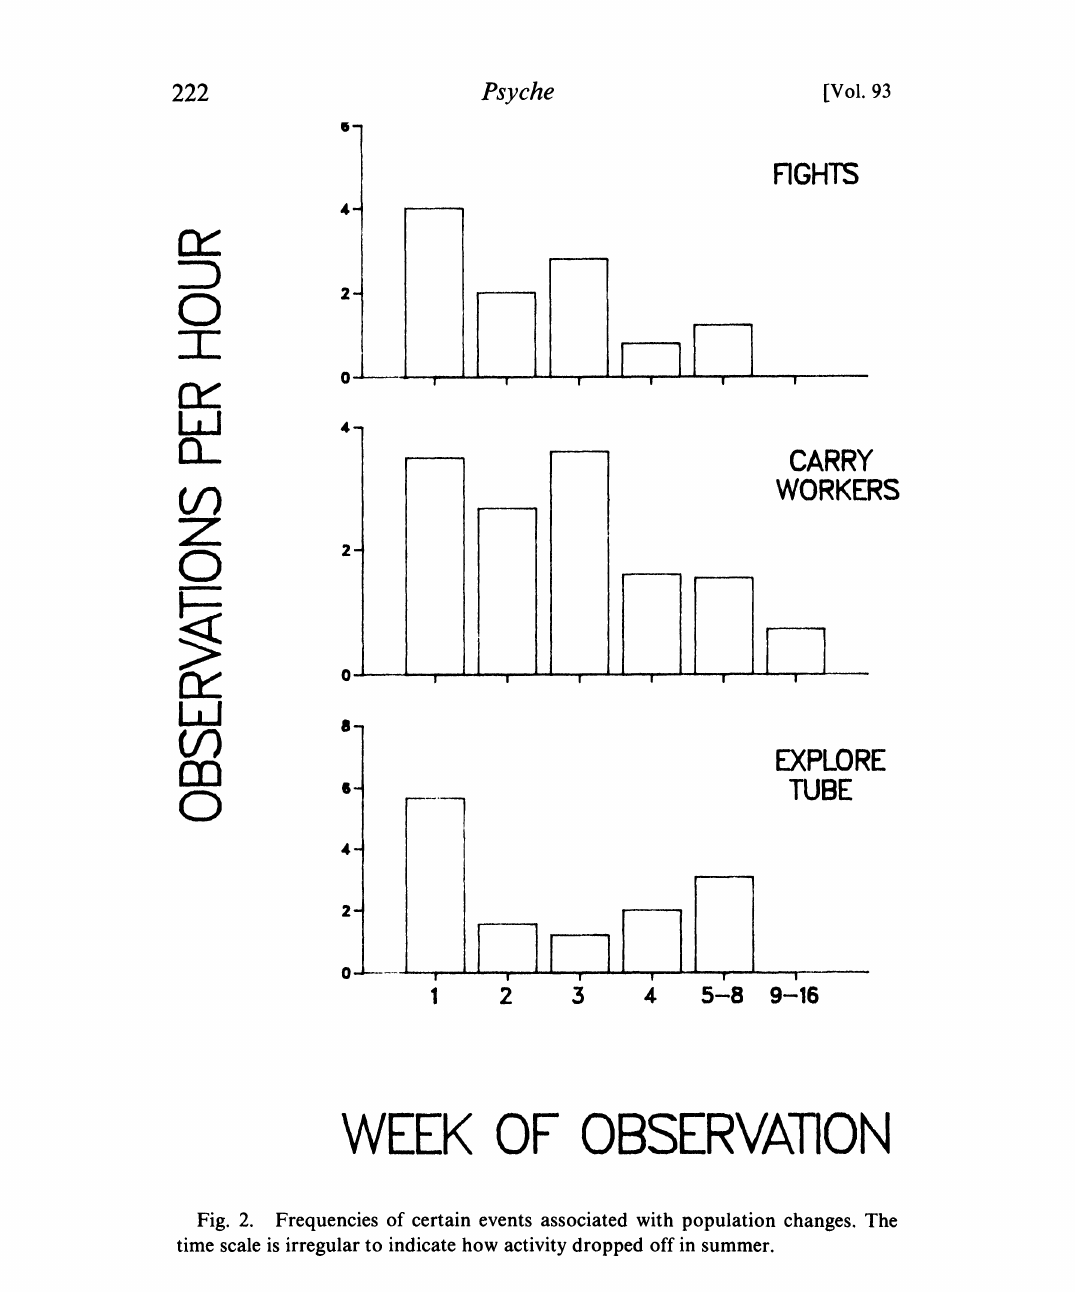
Fig. 2. Frequencies of certain events associated with population changes. The time scale is irregular to indicate how activity dropped off in